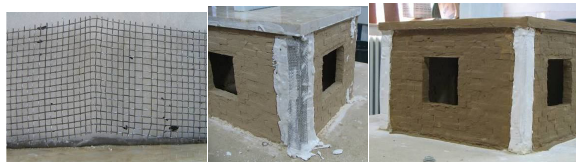
Fig. 20 Wire mesh reinforcement application on the specimen